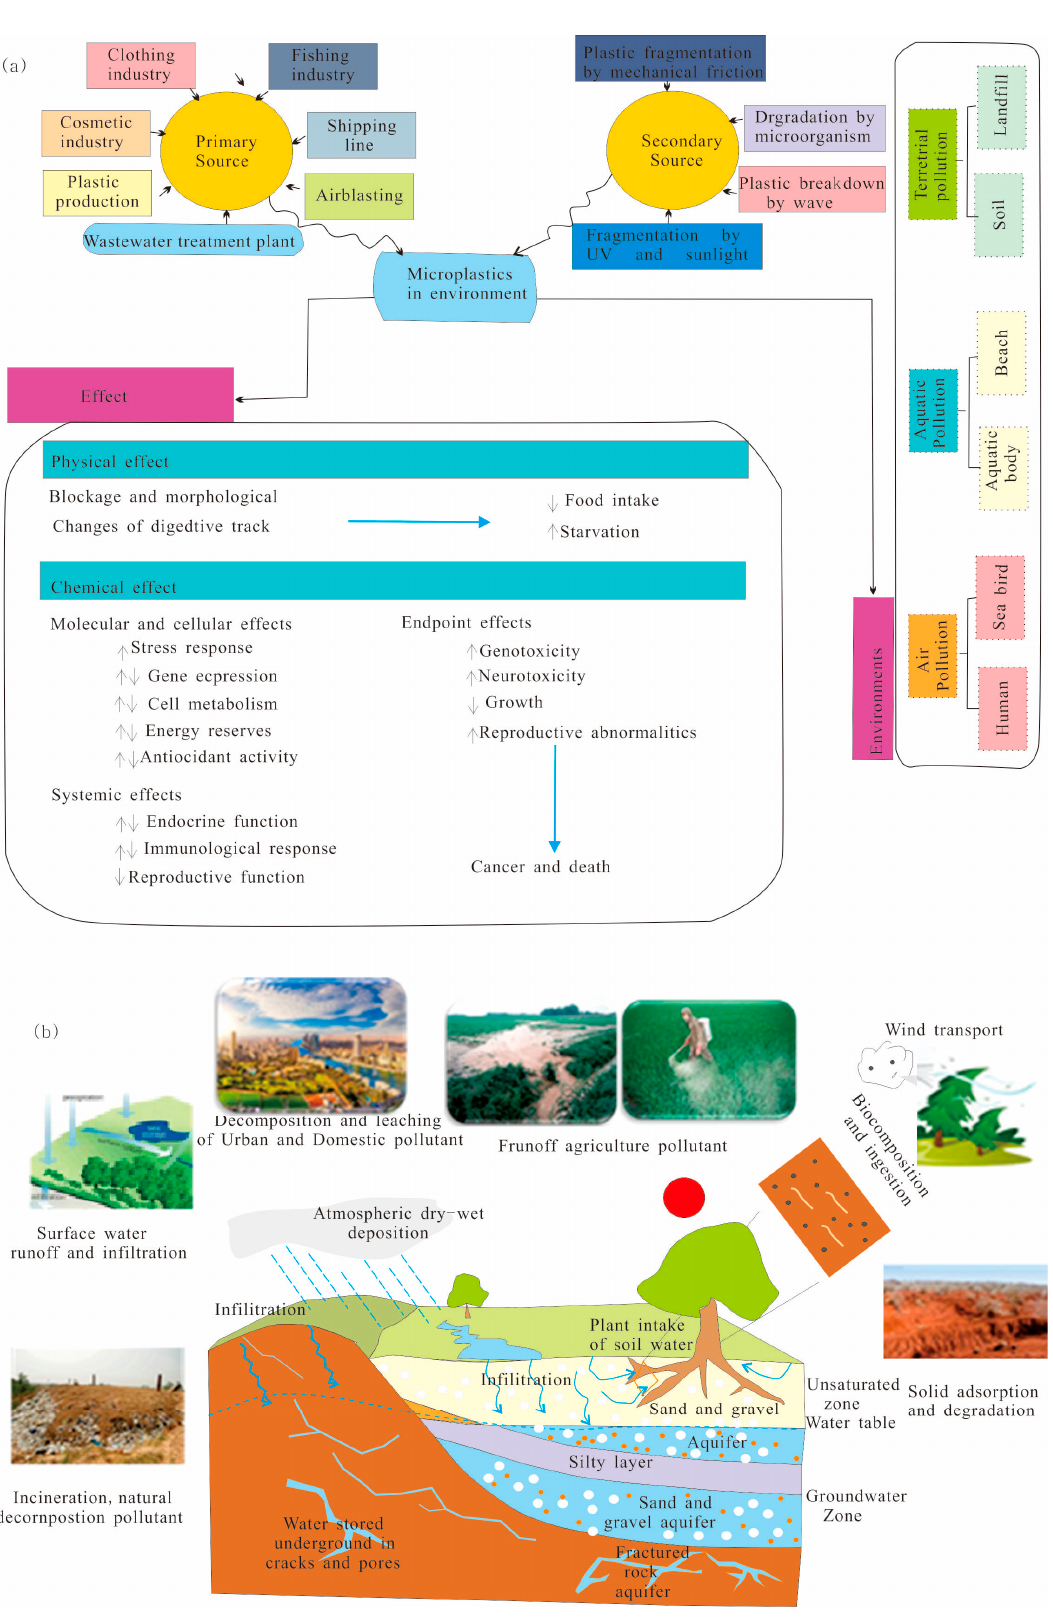
Figure 2. ( a ) Sources, environments, and effects of microplastics after [3] . ( b ) Pollution source and migration of MPs in the vadose zone. migration of MPs in the vadose